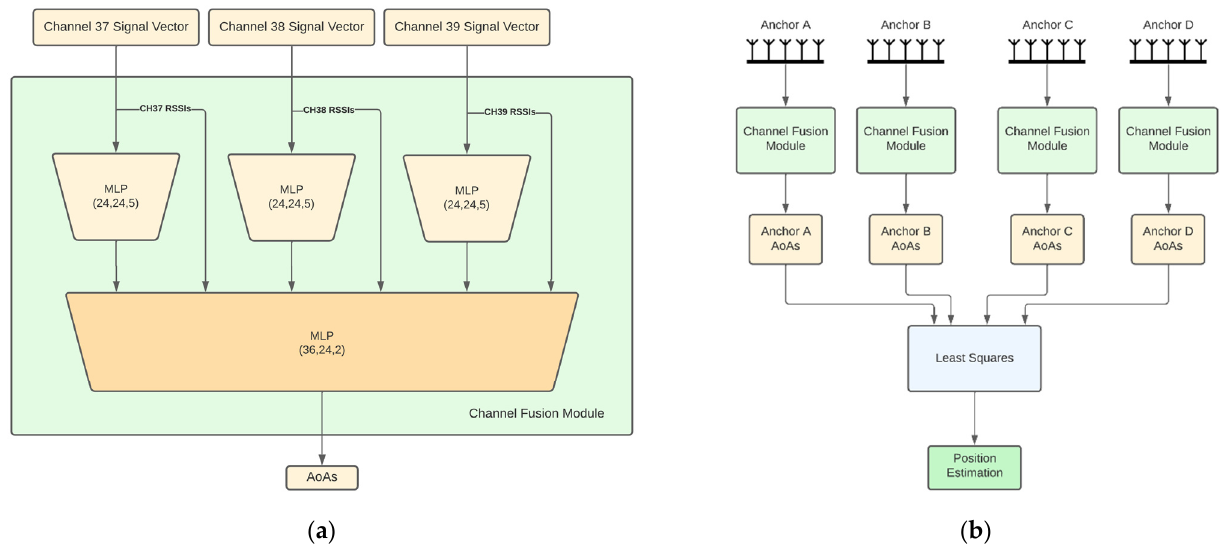
Figure 1. ( a ) Channel fusion module; ( b ) independent AP architecture. Layer sizes for each MLP are shown in parentheses.